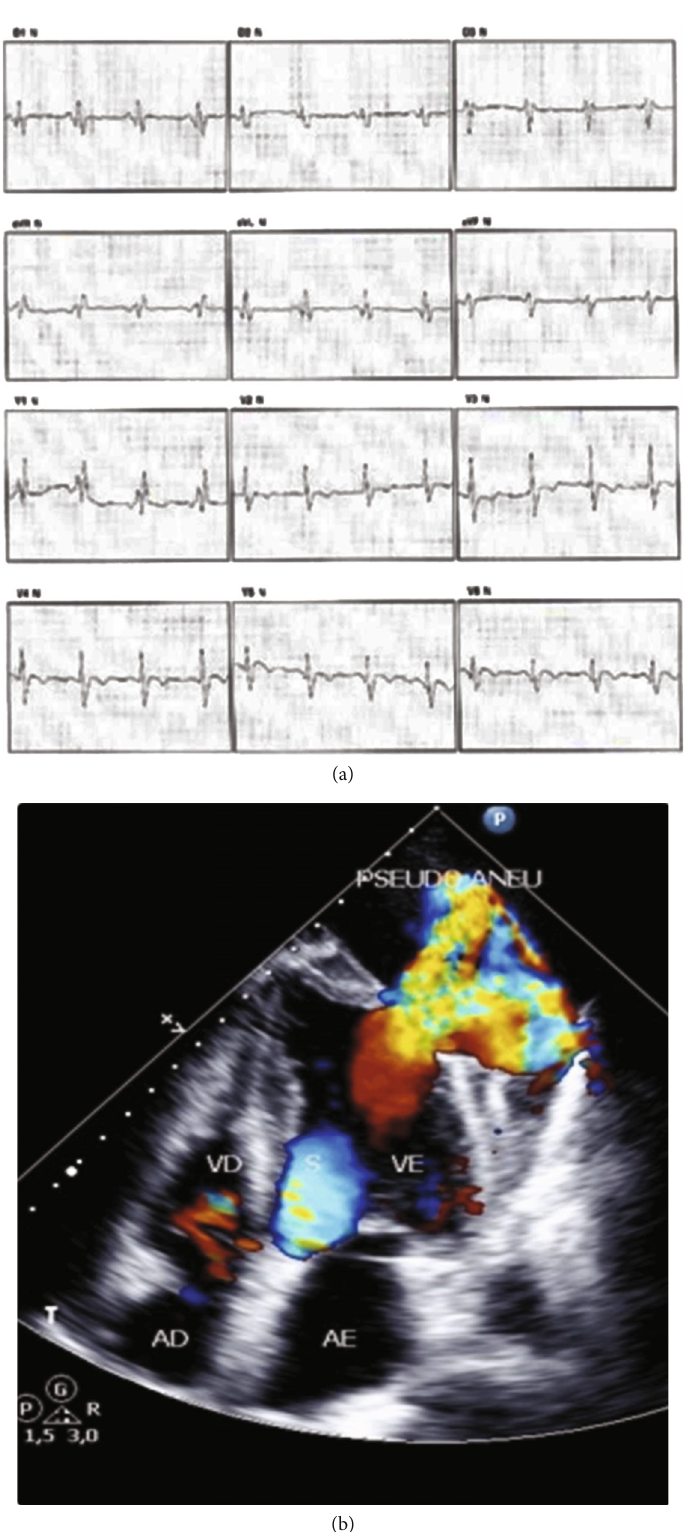
Figure 1: Resting electrocardiogram and transthoracic echocardiogram. (a) Resting electrocardiogram showing right bundle branch block, negative anterior wall T-wave, and lateral wall Q-wave. (b) Transthoracic echocardiogram showing left ventricular pseudoaneurysm and rupture of the apical segment of lateral myocardial wall of the left ventricle. pseudoaneu =pseudoaneurysm; VE=left ventricle; VD =right ventricle; AE =left atrium; AD=right